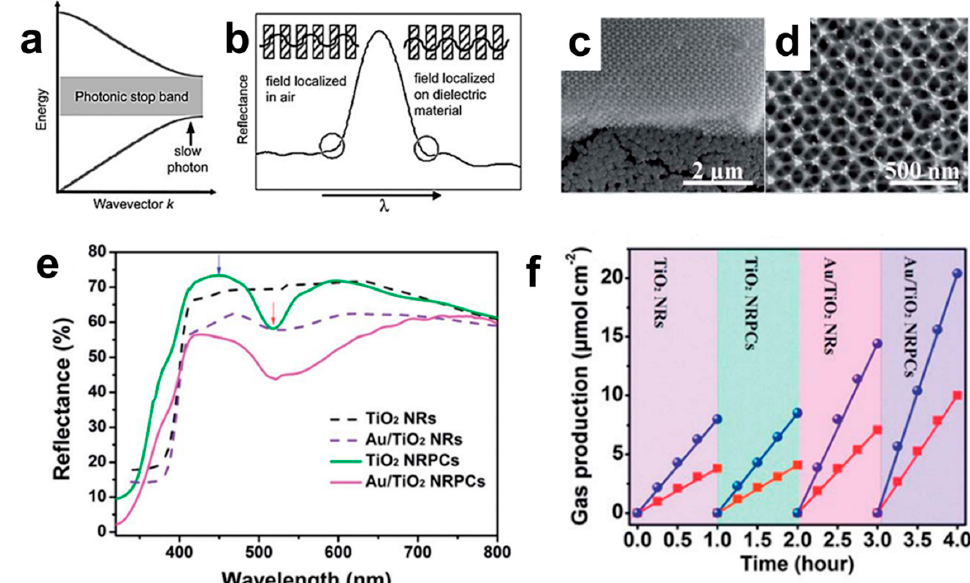
Figure 11. ( a ) Simplified scheme of optical photonic band gap of a photonic crystal; ( b ) the velocity of light slows down at the lower photon energy edge (red edge) and at the higher photon energy edge (blue edge) of the Bragg peak reflection (forbidden wavelength). Adapted with permission from [49]; ( c ) low-magnification and ( d ) high-resolution SEM images of ordered Au/TiO 2 inverse opal film; ( e ) reflectance spectra showing the Bragg peak reflection maxima obtained for different samples compared to the absorbance spectra of TiO 2 ; ( f ) photocatalytic rate of hydrogen and oxygen generation over variable photocatalysts. Adapted with permission from [59].